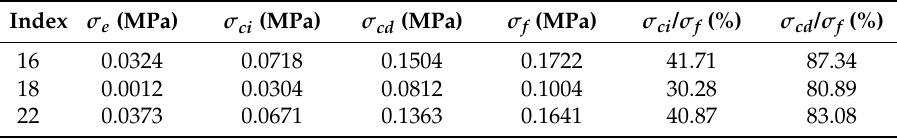
Table 2. Key points of stress and ratios obtained by the fitting-damaging